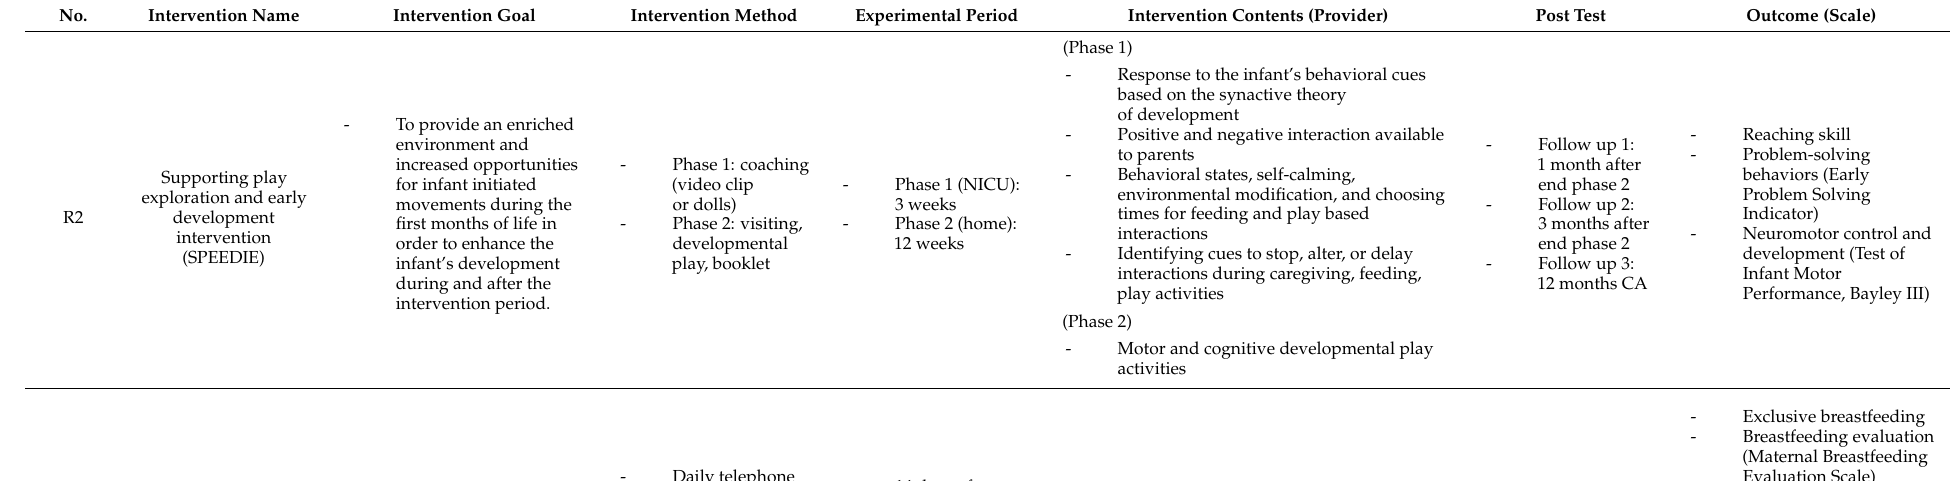
Table 3. Characteristics of follow-up care after NICU